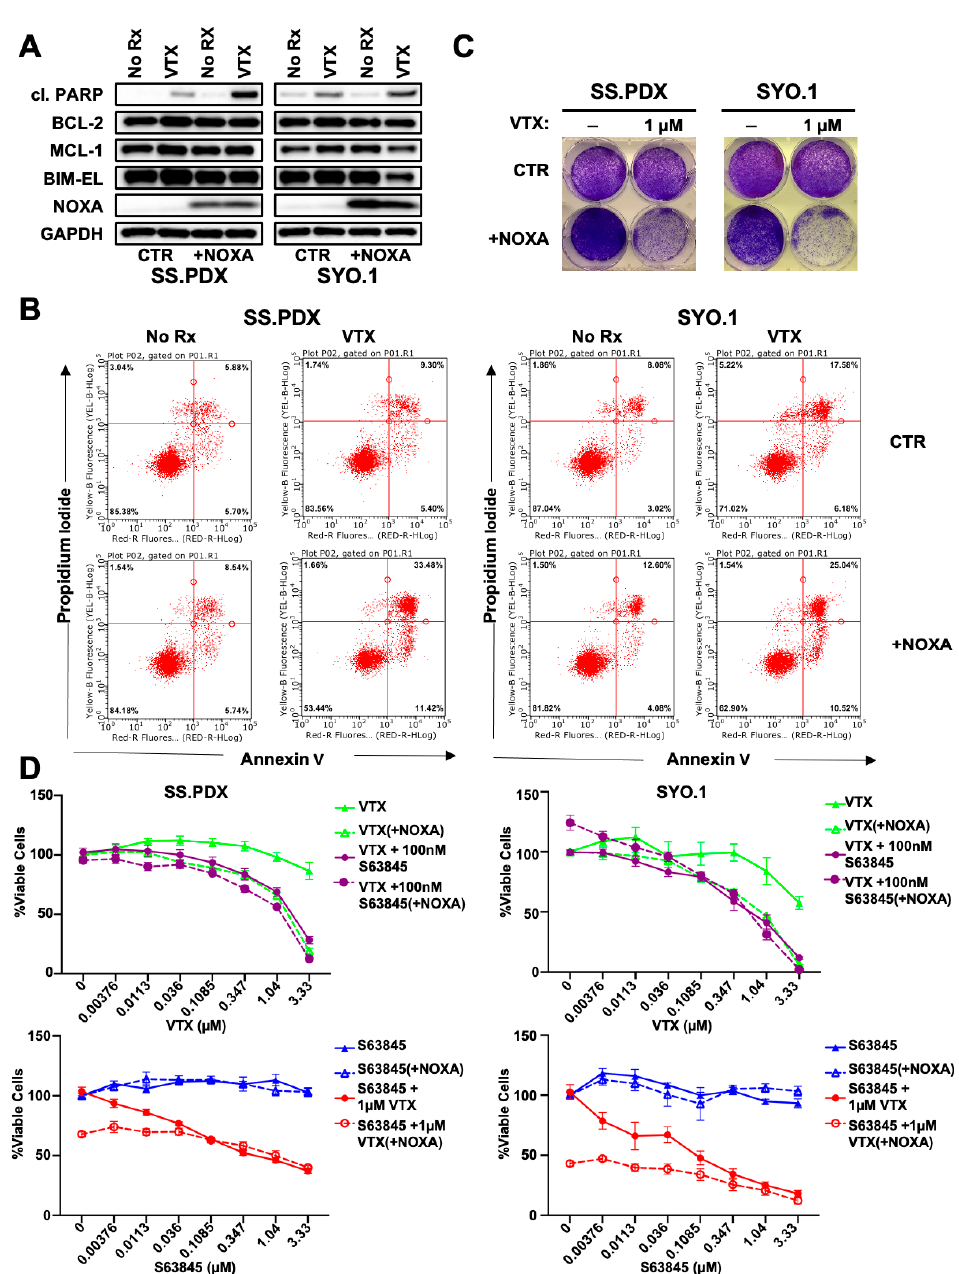
Figure 2. NOXA expression sensitizes SS to venetoclax. ( A ) SS.PDX and SYO.1 cell lines were transfected with a plasmid to overexpress NOXA or an empty vector control (CTR). Following antibiotic-mediated selection, cells were treated overnight with 1 µ M venetoclax (VTX). NOXA expression sensitized SS.PDX and SYO.1 cell lines to VTX, as measured by cleavage of PARP1. ( B ) SS.PDX and SYO.1 control and NOXA-overexpressing lines were treated overnight with 1 µ M VTX or NT control and analyzed for staining of propidium iodide (y-axis) and annexin-V (x-axis). Graphs were divided into quadrants: bottom-left represents viable cells, top-left necrotic cells, bottom-right early apoptotic cells, and top-right late apoptotic cells. Representative experiment of three biological replicates is displayed. ( C ) Crystal violet staining of SS.PDX and SYO.1 cell lines, with or without expression of NOXA, after 7-day VTX treatment, compared to NT control. ( D ) SS.PDX and SYO.1 control or NOXA-expressing cell lines were treated for 72 h with increasing concentrations of VTX or the MCL-1 inhibitor S63845, alone or in combination. Increasing concentrations of VTX were given alone or combined with constant 100 nM concentration of S63845 (Top panels). Increasing concentrations of S63845 were given alone or in combination with constant 1 µ M VTX. Cell viability was analyzed using Cell-Titer Glo (CTG). Error bars indicate standard error of the mean